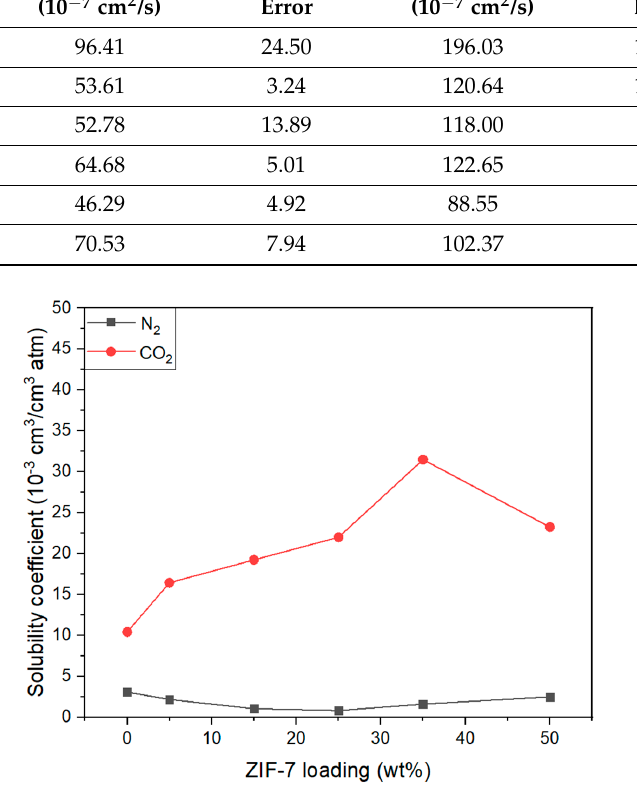
Figure 18. CO 2 and N 2 solubility coefficient of Pebax ‐ 2533/ZIF ‐ 7 composite membranes.